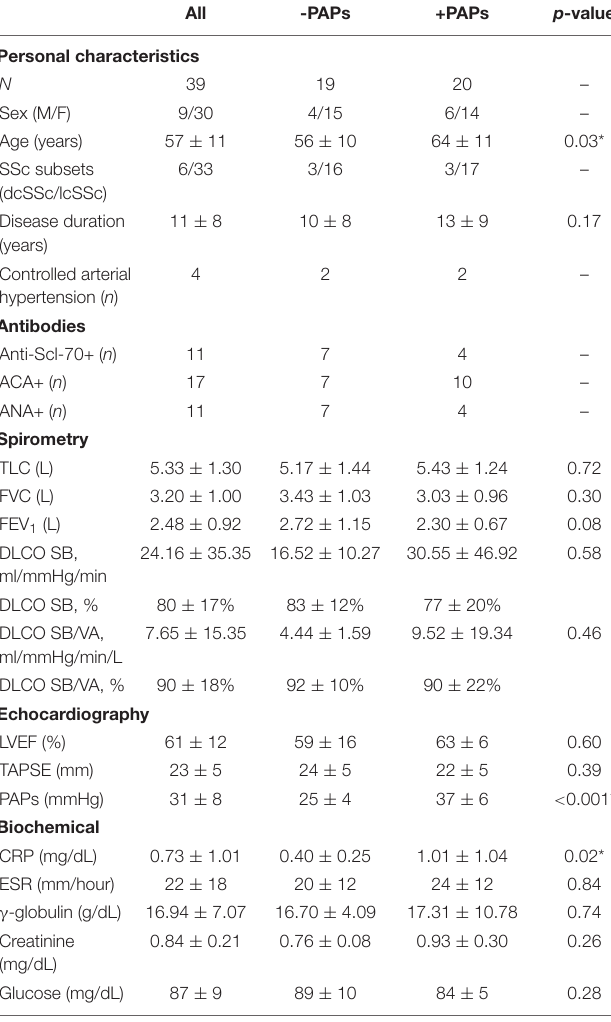
TABLE 1 | Participants’ characteristics and clinical